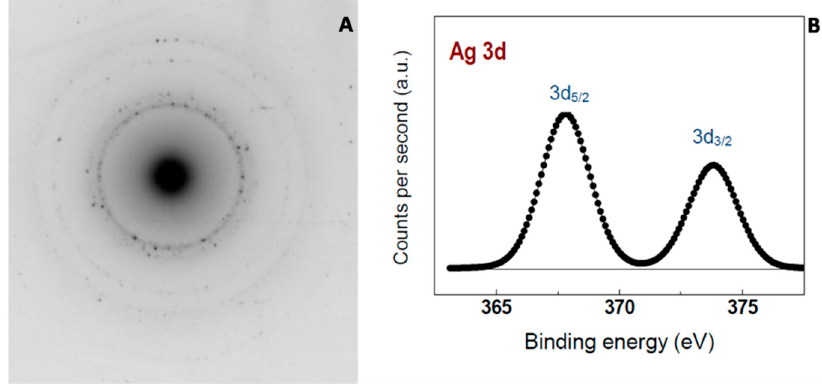
Figure 5. Metallic nature of AgNPs. Diffraction pattern ( A ) and X ‐ ray photoelectron spectroscopy (XPS) spectrum ( B ) of the AgNPs produced by UV irradiation.